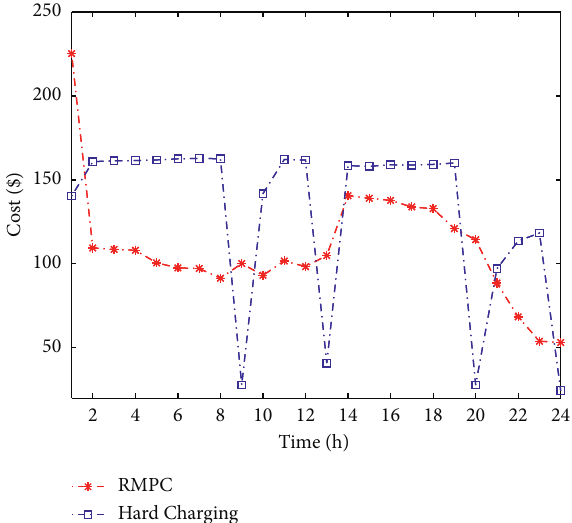
Figure 9: Comparison of operation cost between RMPC and HC method.